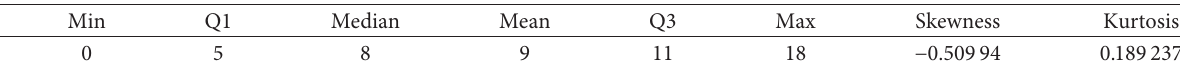
Table 9: Descriptive statistics for the data of COVID-19 mortality numbers in